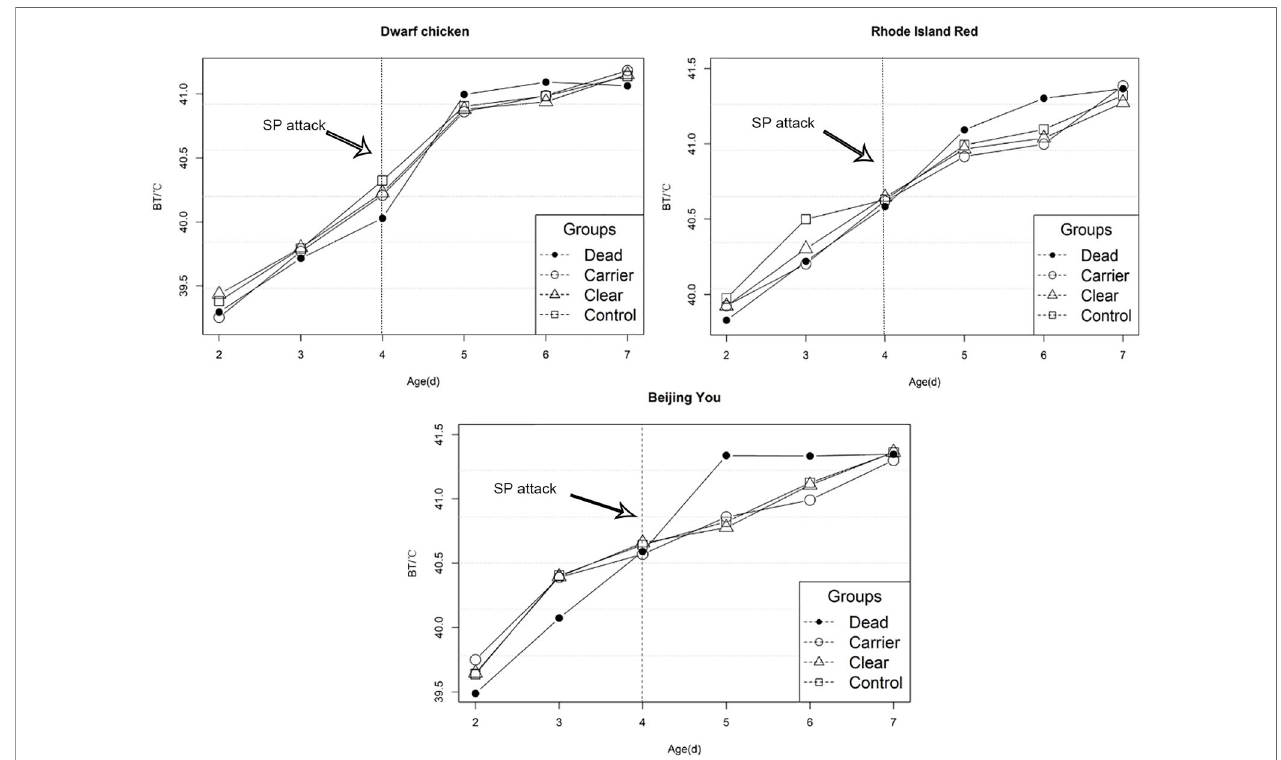
FIGURE 2 | Early body temperature variation before and after salmonella infection. Chicks were challenged with SP at 4 days of age.